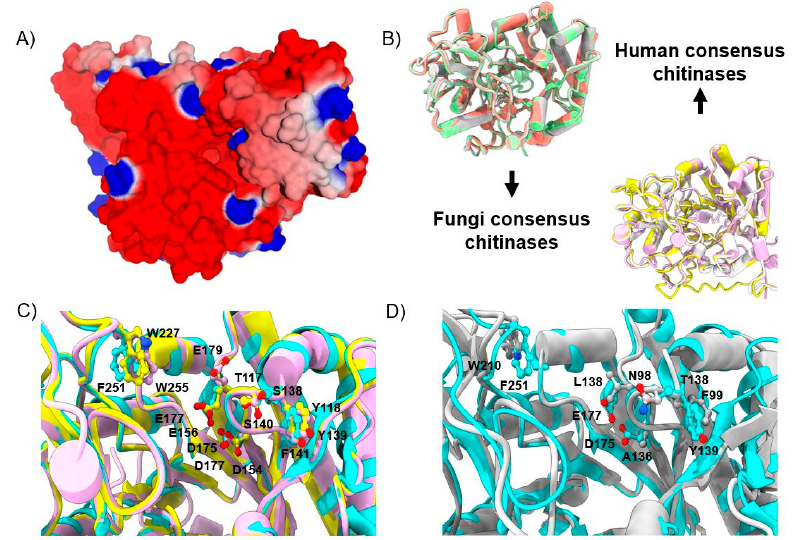
Figure 3. AfChiB1 crystal structure protein data bank with code 3CH9 (PDB: 3CH9) and structural alignment with consensus homology models. ( A ) Molecular electrostatic potential (MEP) surface and catalytic cavity (highlighted by a rectangular form) of chitinase AfChiB1; blue, red and white colored regions indicate positive, negative and zero values of MEP, respectively. ( B ) Structural alignment of the fungi consensus model, and human consensus chitinases. ( C ) Catalytic site of fungi-predicted structures; 3CH9 representation is colored in blue. ( D ) Structural alignment of human consensus model against 3CH9 colored in blue. Key residue differences are highlighted by ball and stick representation.